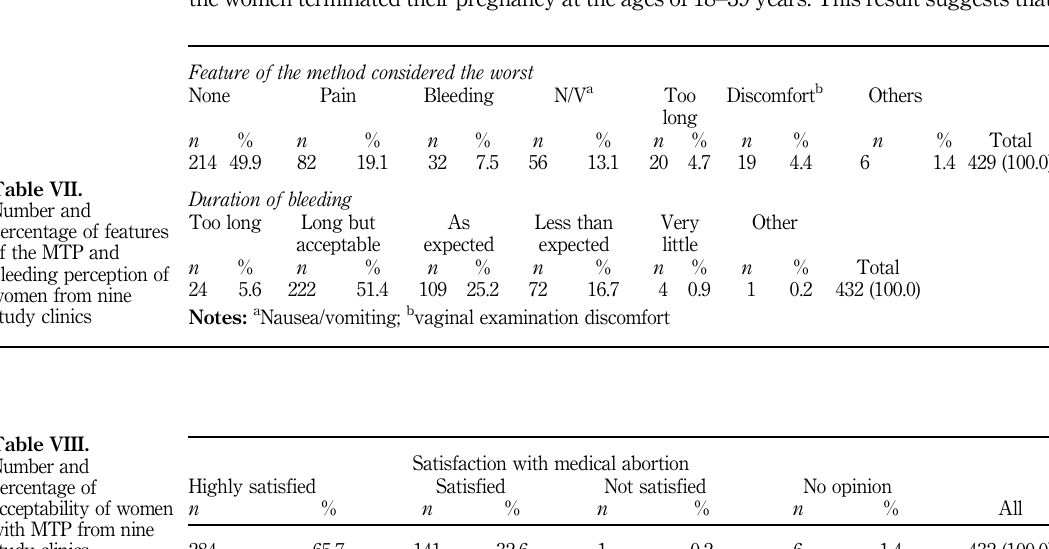
percentage of acceptability of women with MTP from nine study